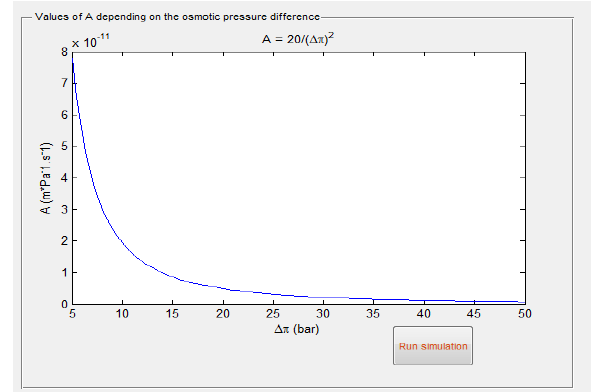
Figure 2 . Permeability Coefficient vs Osmotic Pressure